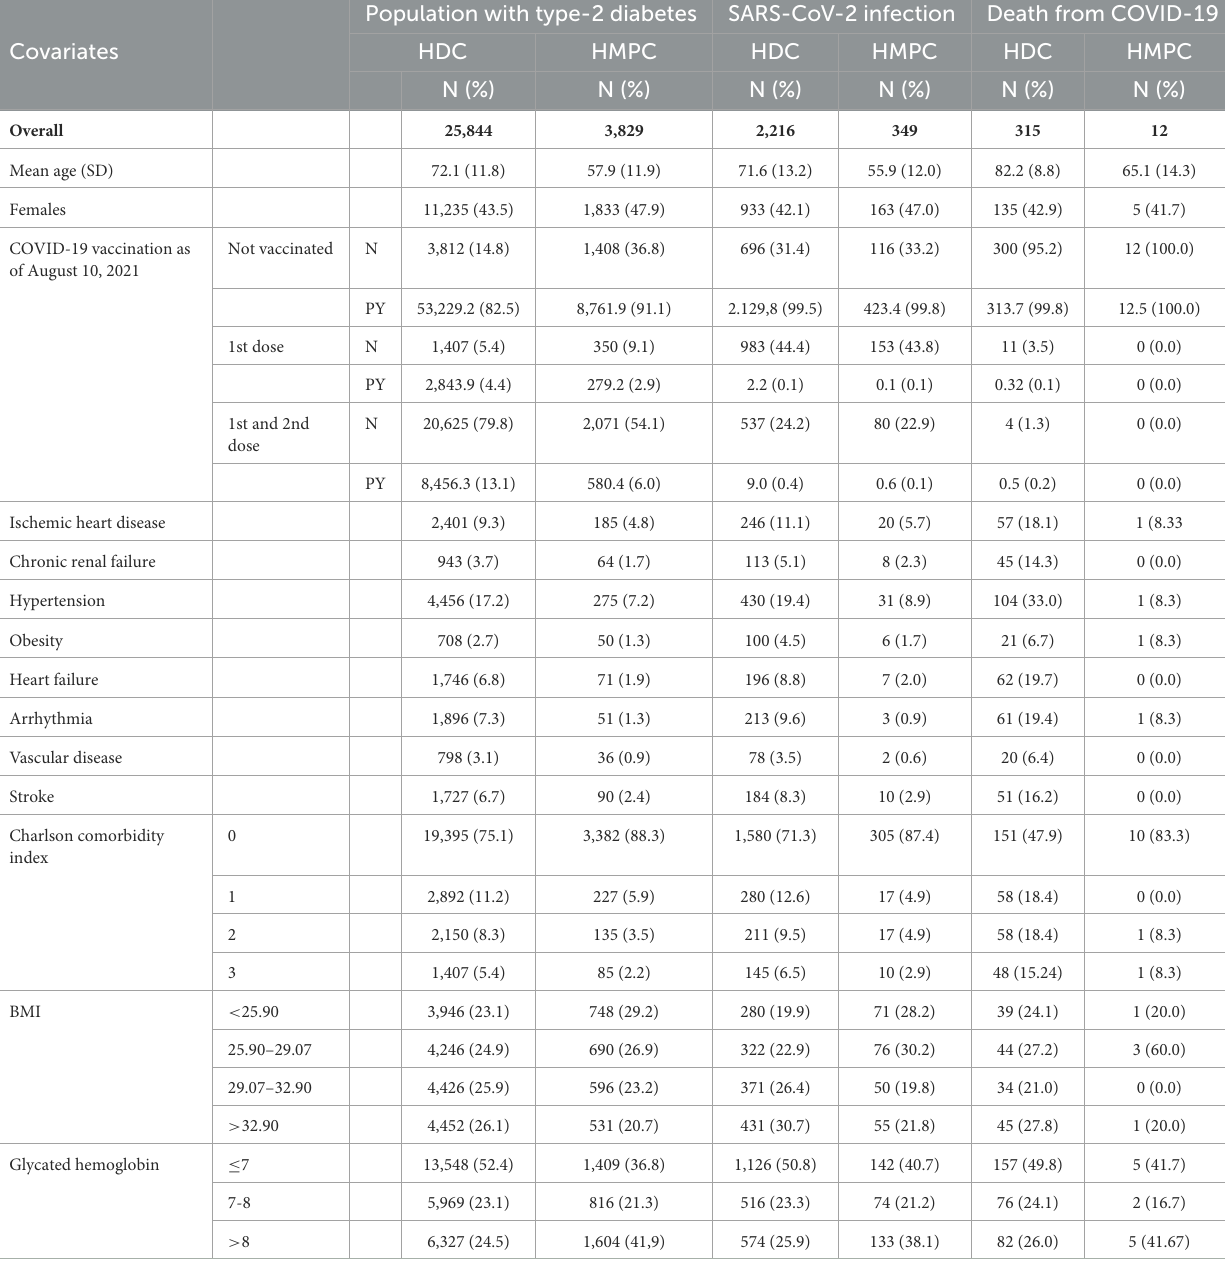
TABLE 3 Population with Type-2 diabetes residing in the province of Reggio Emilia, numbers and percentages of first infections of SARS-CoV-2 and deaths from COVID-19, by demographic and clinical characteristics. Population with type-2 diabetes SARS-CoV-2